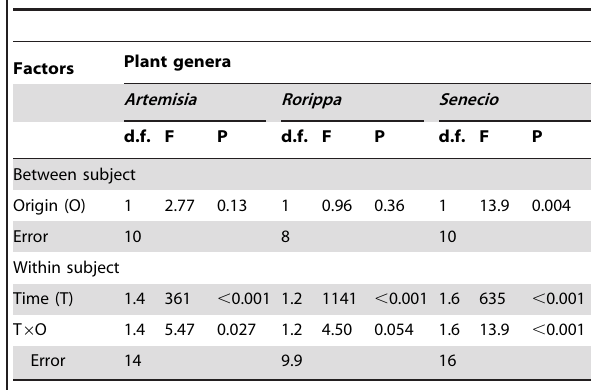
Table 2. Repeated-measure ANOVA for soil